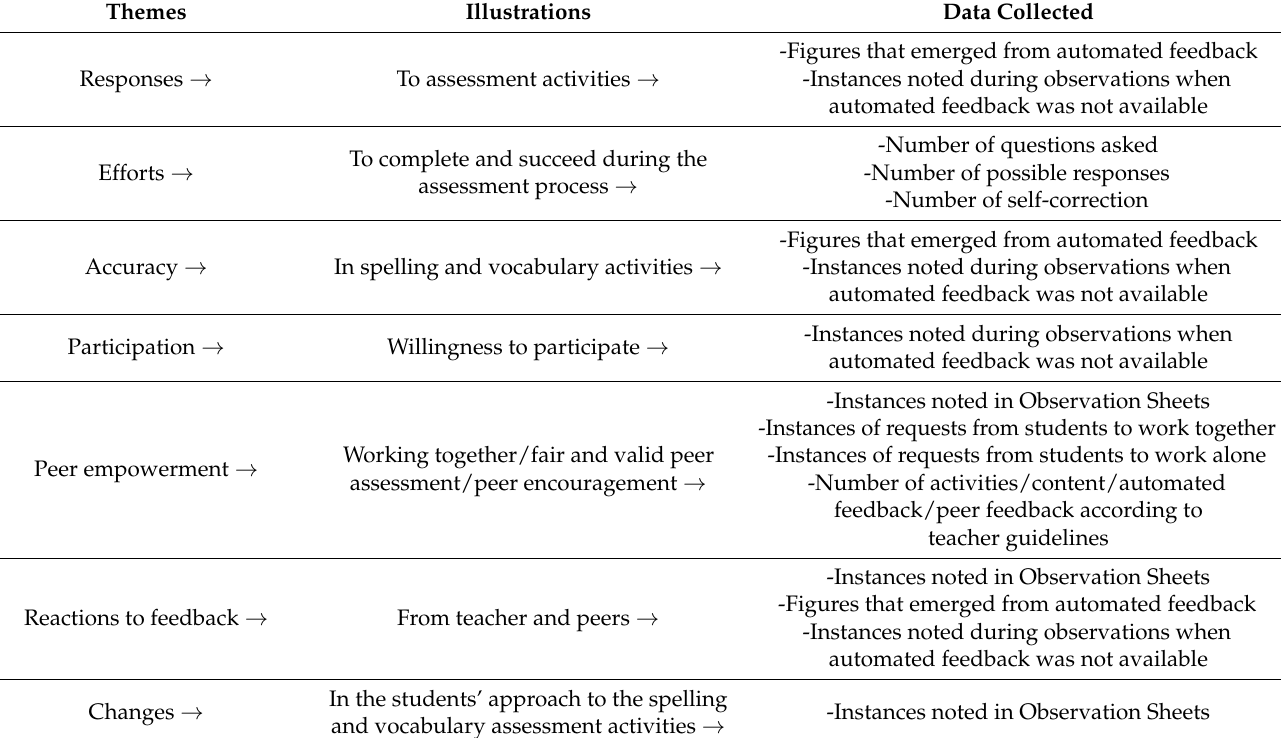
Table 3. Illustration of emerging